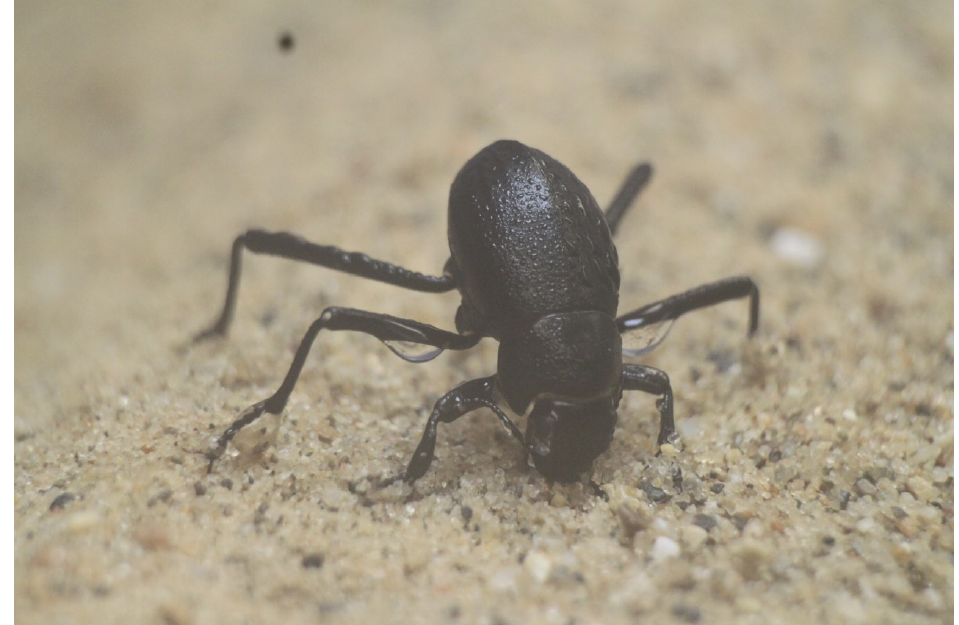
Figure 1. Photograph of an Onymacris unguicularis beetle in the basking position, showing the typical downward head stance, which allows its legs and the rest of its body to collect water. The photograph was taken in our laboratory during experiments with live